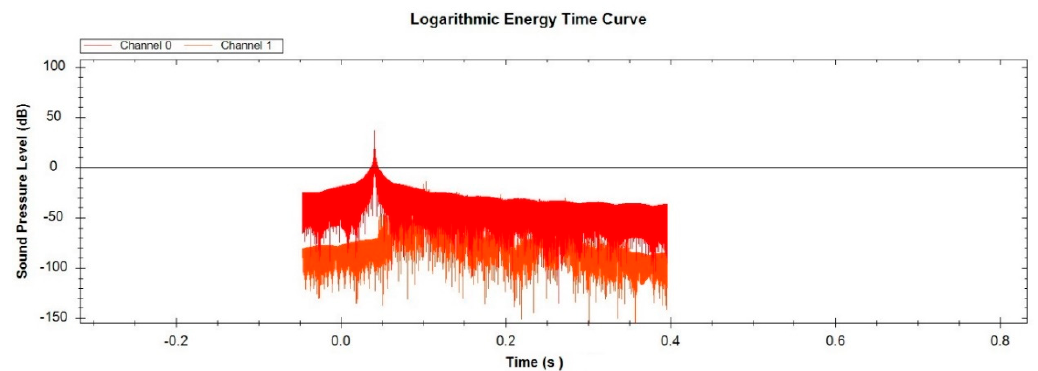
Figure 9. Logarithmic energy time curve for the hall with acoustic treatment, with channel 0 for hall in unoccupied mode and channel 1 for occupied mode.